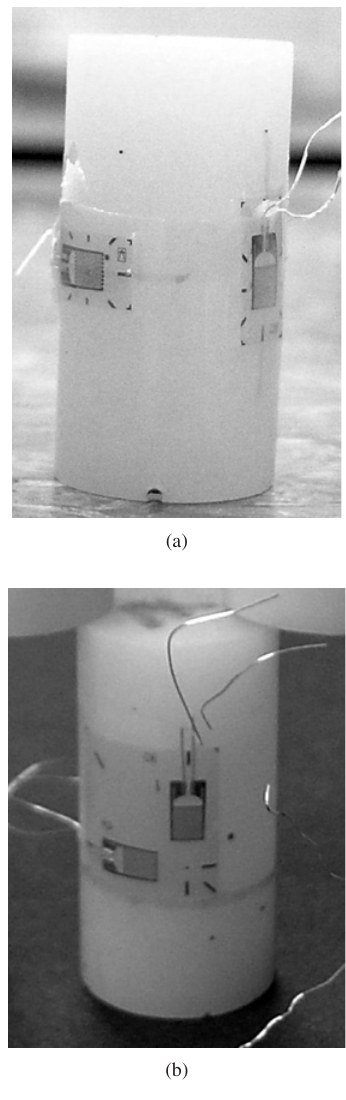
Figure 8. Placement of strain gages: a) uniaxial strain gages placed longitu- dinally and transversally; and b) biaxial strain gages.